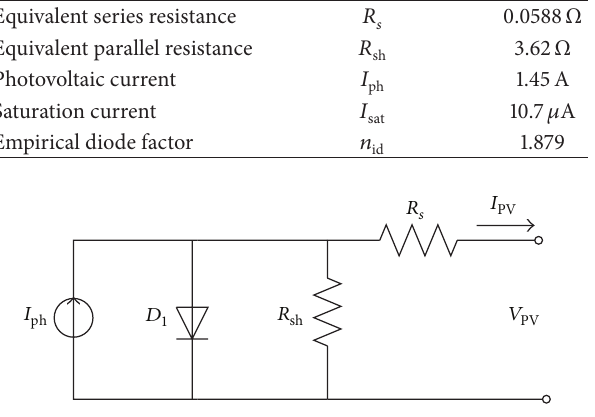
Figure 1: The solar cell equivalent circuit, the single-diode model.